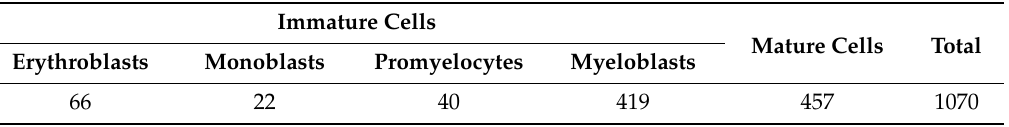
Table 2. Amount of data remaining after segmentation for four immature leukocyte types, total immature leukocytes, and total mature